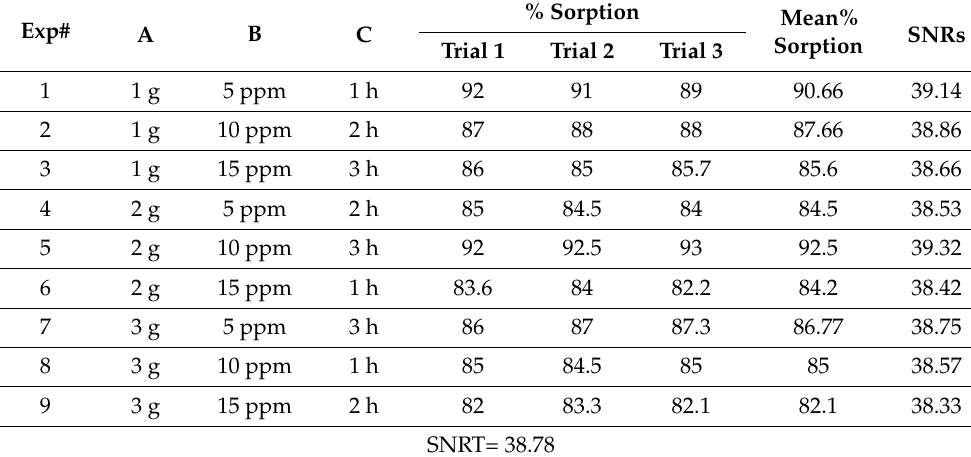
Table 2. Mean percentage sorption and SNRs for the experiments designed by L9 orthogonal array for Cr on defatted seed residue of C. melo